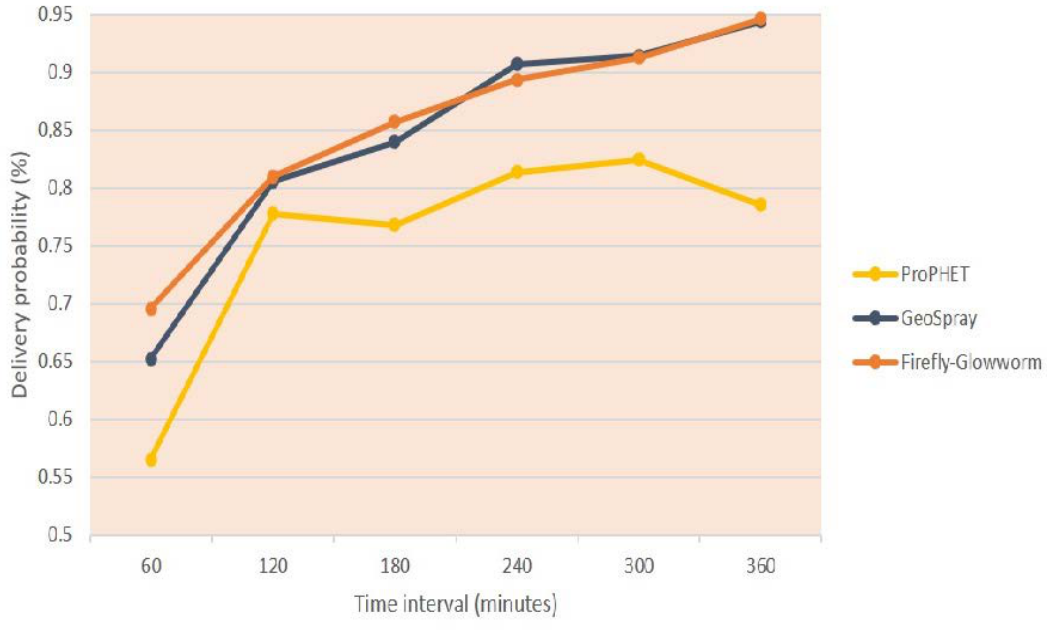
Figure 6. Delivery probability. Figure 6. Delivery Probability.